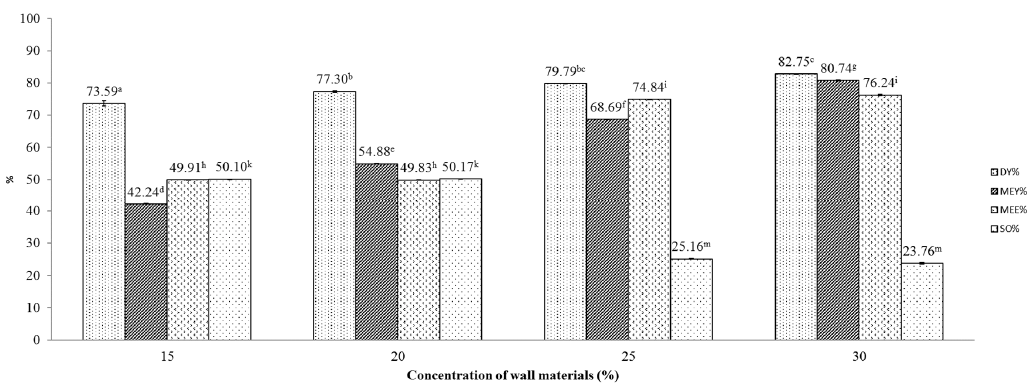
Figure 3. Effect of maltodextrin:gum Arabic mixture (4:1) concentration on various indicators of the microencapsulation process. Figures with same letters indicate statistical indifference